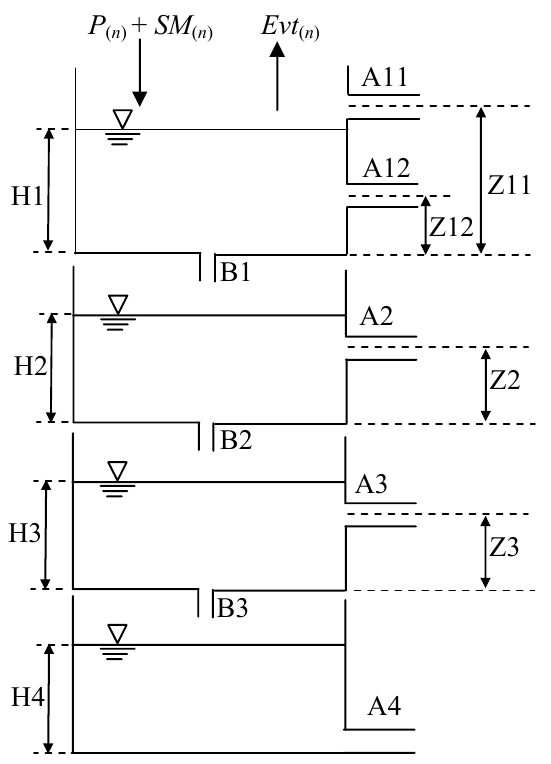
Fig. 2 Tank model structure for runoff estimations. Fig. 2. Tank model structure for runoff